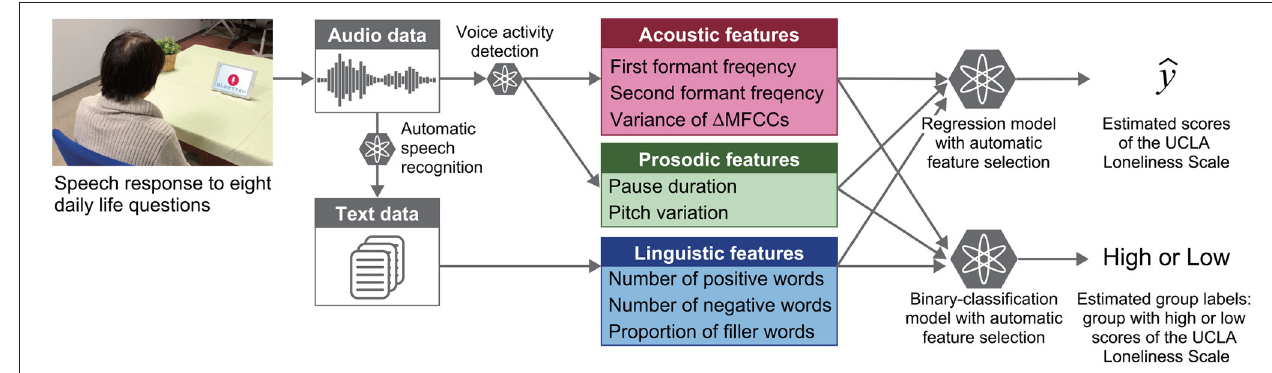
FIGURE 2 | Overview of automatic analysis pipeline for estimating loneliness scores and for detecting individuals with high loneliness scores from speech responses to daily life questions.